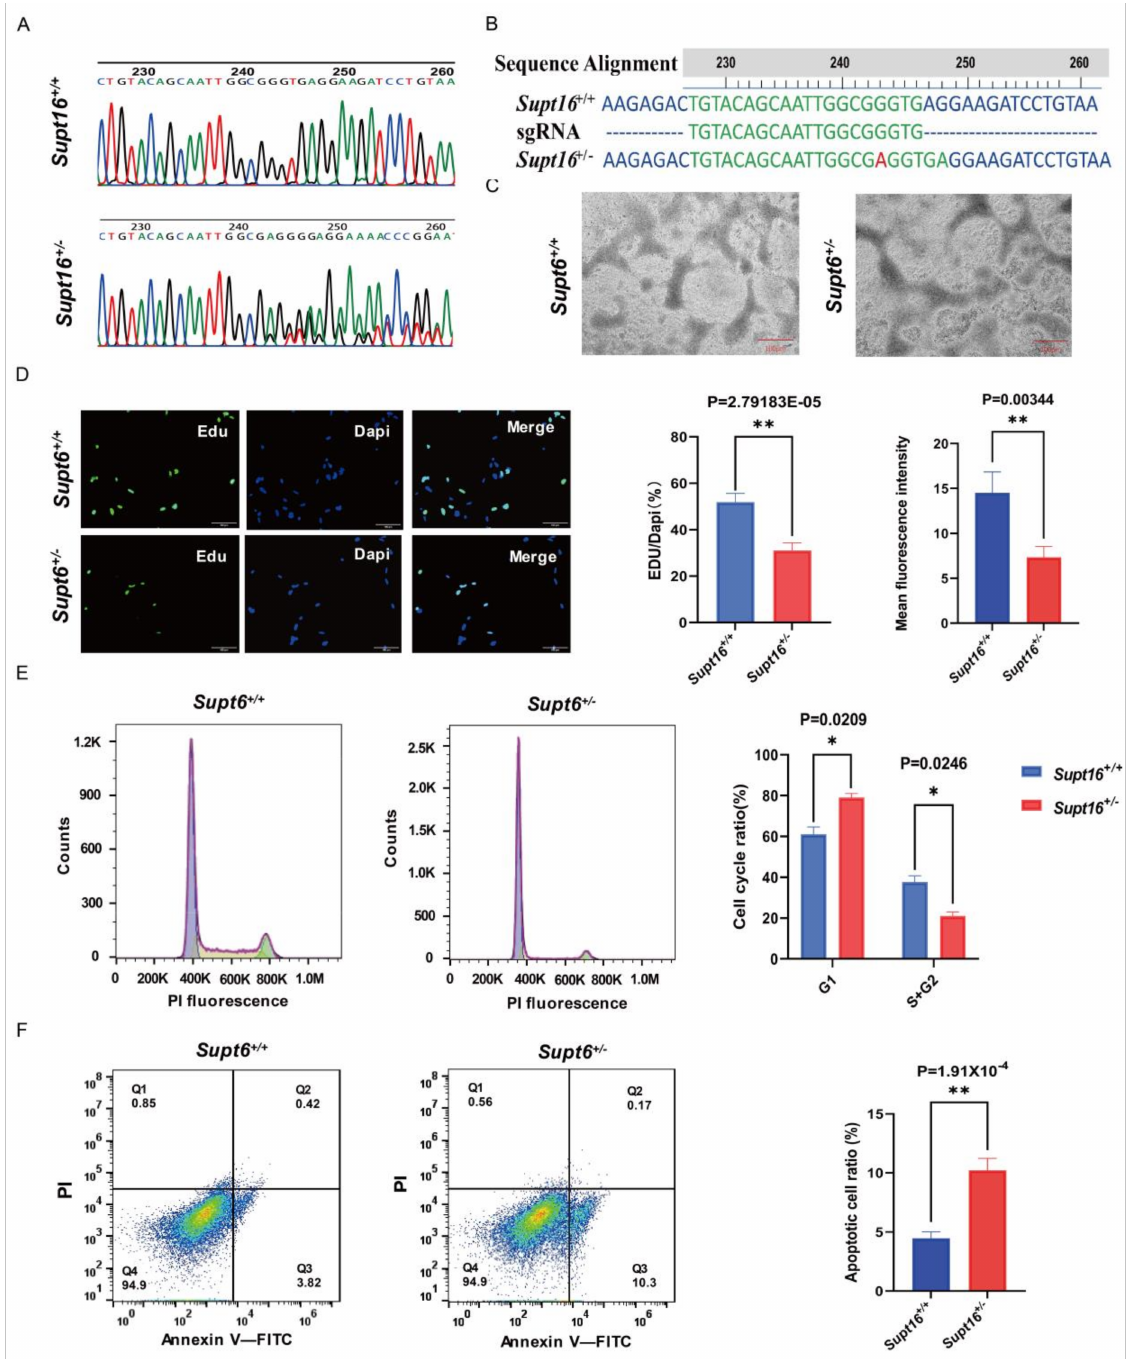
Figure 1. Supt16 haploinsufficiency disrupts the self − renewal of human iPSC − derived NSCs. ( A ) Sanger sequencing of Supt16 heterozygous hNSCs clone after CRISPR/Cas9 − mediated. ( B ) Supt16 +/ − hNSCs exhibit a point mutation in the form of an adenine nucleotide insertion (red hyphen). ( C ) Representative pictures of neural rosettes derived from Supt16 +/ − haploinsufficiency and wild-type iPSCs; scale bar, 100 µ m. ( D ) Representative immunofluorescence images of EdU incorpora- tion assay ( n = 3 samples per genotype. Green: EdU − positive cells. Blue: DAPI. Scale bar, 100 µ m). ( E ) Representative flow cytometry analysis picture of hNSCs cell cycle (left). Quantitative analysis of hNSCs cell cycle distribution (right) ( n = 3 samples of each genotype). ( F ) Representative flow cytometry analysis picture and quantification of hNSCs apoptotic rate ( n = 3 samples of each genotype). The error bars represented the mean ± SD and the significance level was calculated by Student’s t − test (two − tailed, equal variance) (ns means not statistically significant, * p < 0.05, ** p <